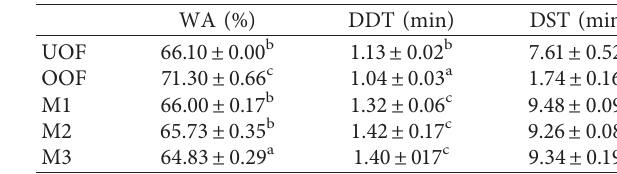
Table 1: The Mixolab parameters of wheat flour added with dif- ferent ratios of overozonized wheat flour † .